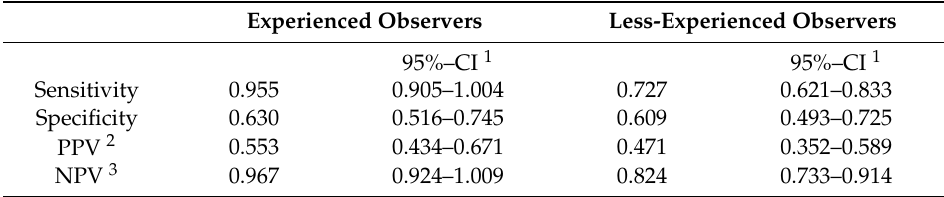
Table 2. Sensitivity, specificity, and positive and negative predictive values, according to the evaluation of experienced and less-experienced observers (values averaged over observers with 95% confidence intervals).